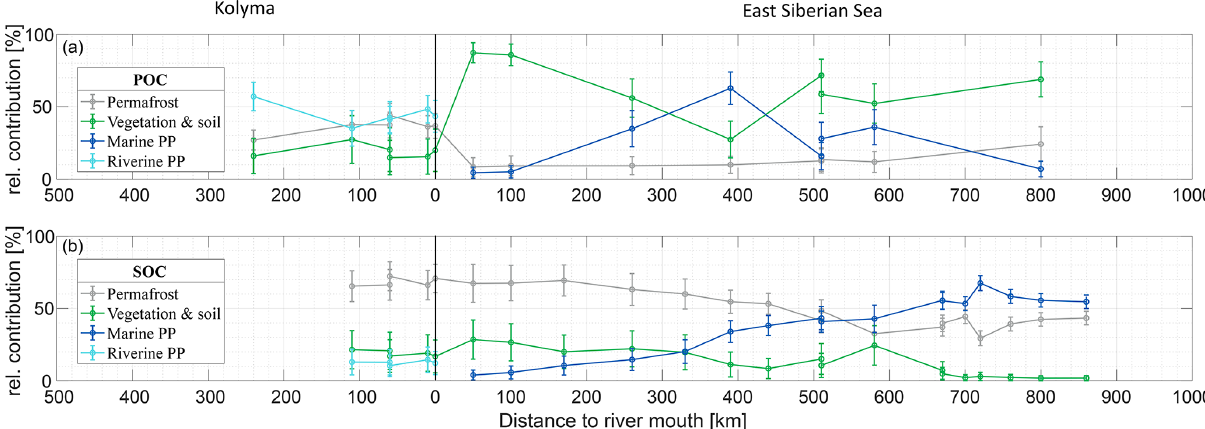
Figure A2. Mean relative contribution (plus and minus one standard deviation from Monte Carlo simulations) of three endmembers over transect distance for (a) surface water particulate organic carbon (POC) and (b) sediment organic carbon (SOC), based on dual carbon isotope ( (cid:49) 14 C and δ 13 C) endmember analyses (EMMA). For the riverine part of the transect (Kolyma; left side of the figure), the endmembers are: Permafrost organic carbon (OC) in grey, Vegetation/soil OC in green, and Riverine primary production (PP) OC in cyan. For the marine part of the transect (East Siberian Sea; right side of the figure), the endmembers are: Permafrost OC in grey, Vegetation/soil OC in green, and Marine primary production OC in dark blue. This figure was made using the alternative Marine PP endmember ( δ 13 C = − 21 ± 1‰), for comparison to Fig. 4 of the main text, which uses the Marine PP endmember of − 24 ± 3‰.